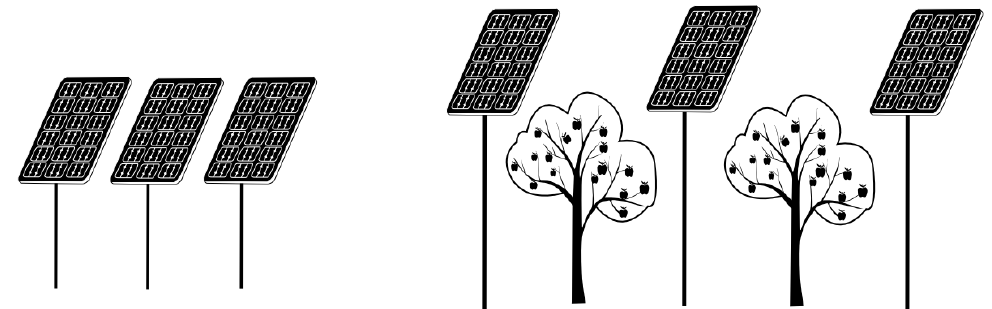
Figure 1. Schematic comparison of PV and APV systems.